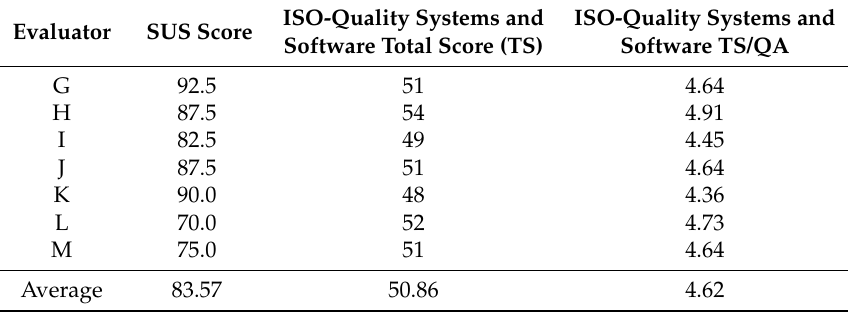
Table 5. Expert panel scores from the first and second parts of the